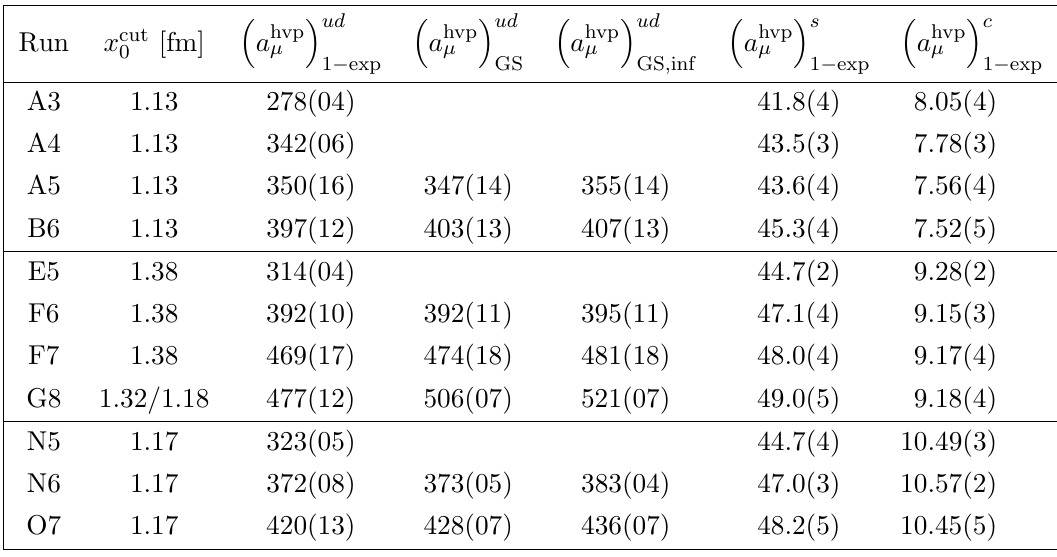
Table 5 . Results for a hvp in units of 10 (cid:0) 10 determined from the time-momentum representation (cid:22) along with the Euclidean time x cut